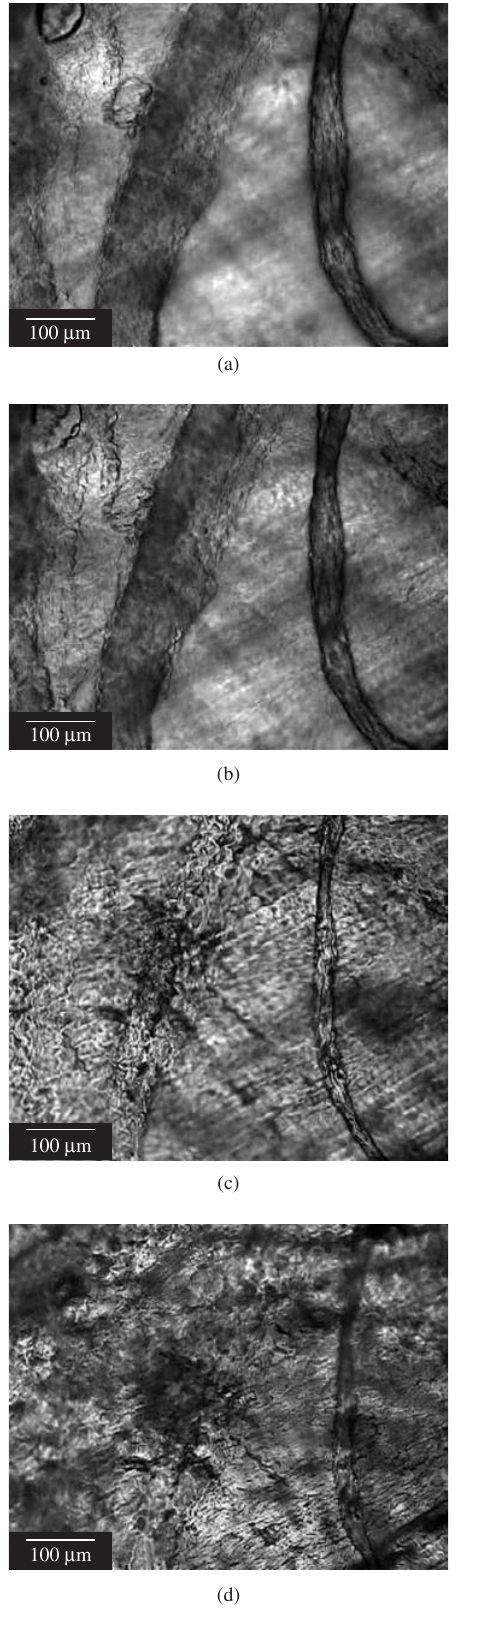
Figure 3. Freeze-drying microscope photographs of GA bovine pericardium at different temperatures: a) 30.5 °C; b) 40.8 °C; c) 49.9 °C; and d) 59.9 °C. Heating rate of 10 °C.min -1 .